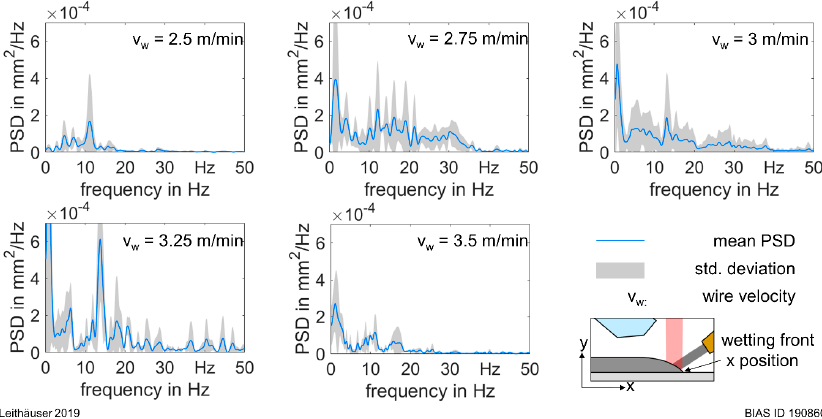
Figure 12. Mean PSDs and standard deviations of the wetting front for wire feed rates between 2.5 and 3.5 m/min.